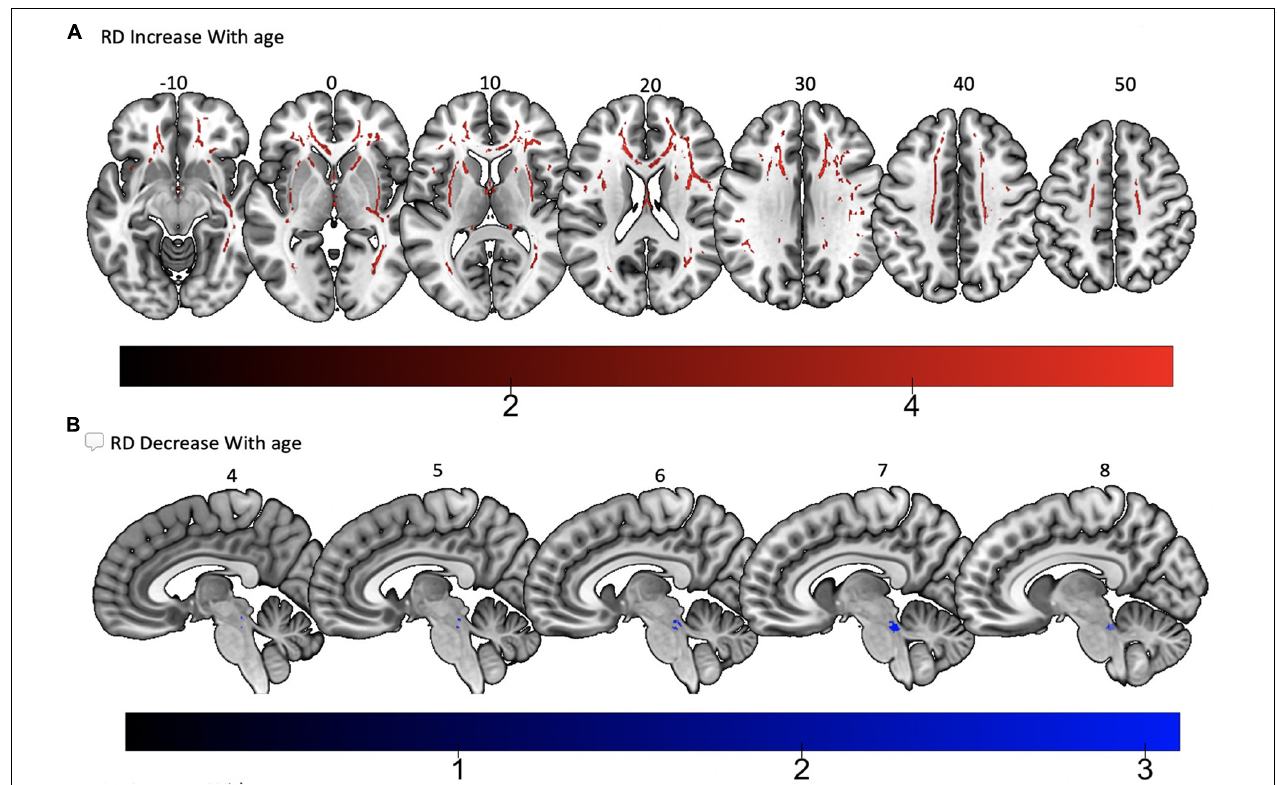
FIGURE 7 | Significant correlations between (A) RD increase with age and (B) RD decrease with age ( p < 0.05, cluster-wise FDR corrected for multiple comparisons). Pictures are in neurological convention with left side in the figure corresponding to the left side of the